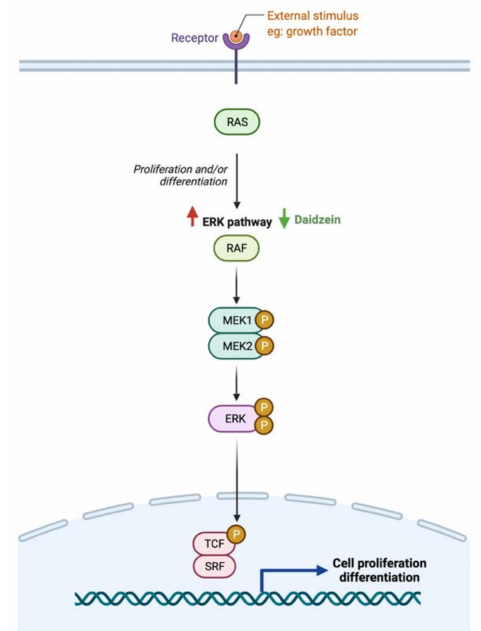
Figure 7. Schematic illustration of the impact of flavonoids on ERK pathway. Red arrows represent the effects of GI cancer on the pathway, while the green arrows illustrate the impact of flavonoids on the pathway. Created with BioRender.com (accessed on 3 August 2021).